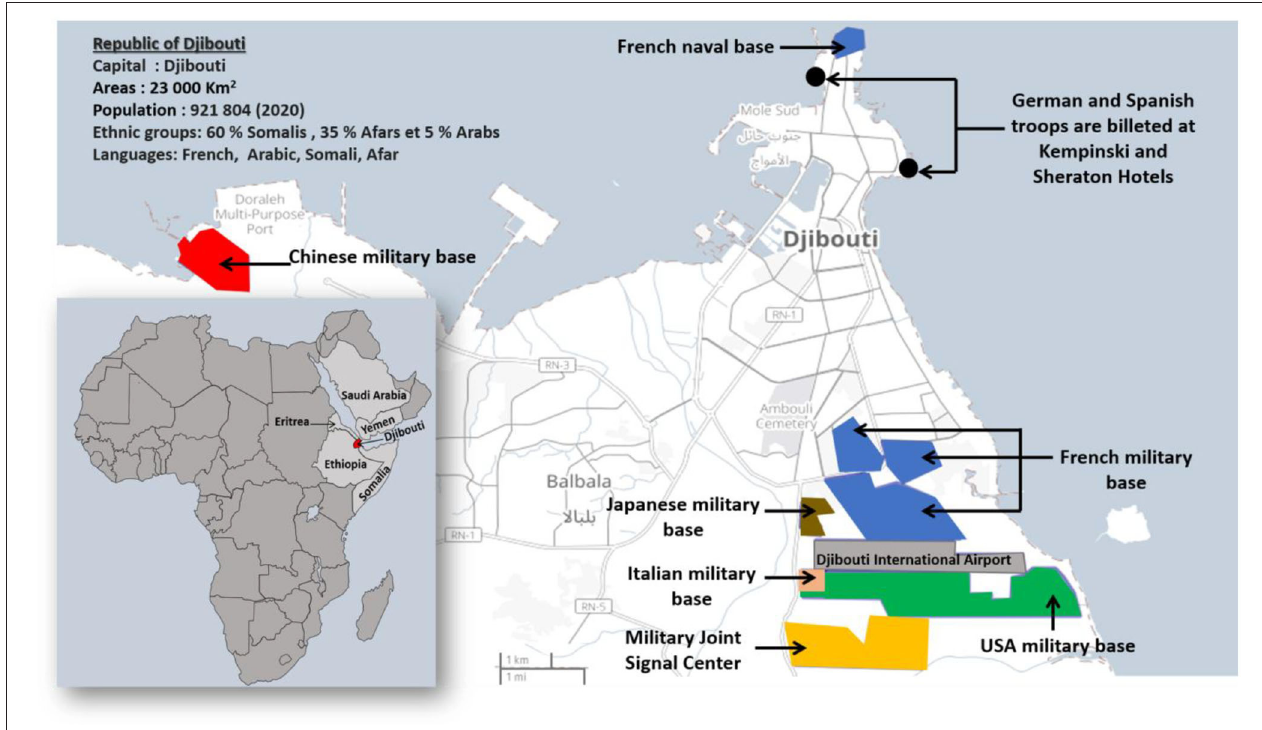
FIGURE 1 | Map of Djibouti. The Republic of Djibouti is located in the horn of East Africa. In 2020, the population of the Republic of Djibouti consisted of 60% Somalis, 35% Afars, and 5% Arabs with a total of 921,804 inhabitants. The map of Dijbouti was adapted from the Open Street Map (http://umap.openstreetmap.fr/). The geographical and geopolitical situation of Djibouti is interesting because it hosts several military bases and forces from different countries including France, Italy, Germany, Spain, China, the USA, and Japan.